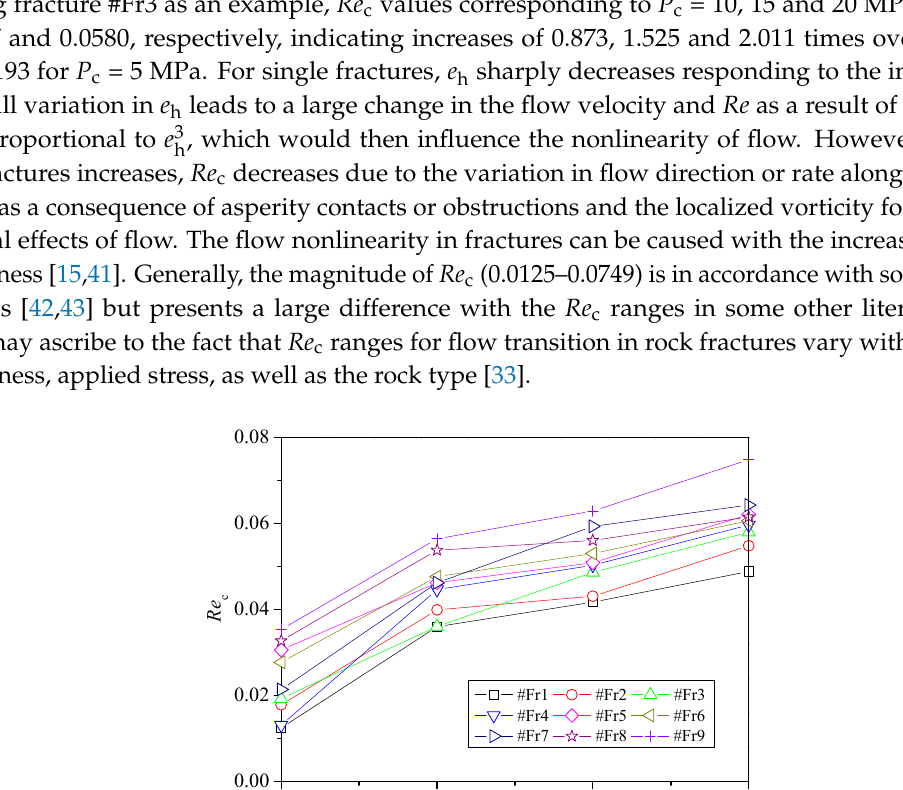
Figure 9. Critical Reynolds number Re c of rough-walled fractures versus the confining pressure. Apparent transmissivity is the product of permeability and cross-sectional area of rock fractures. If the nonlinear deviation term ( bQ 2 ) is inappreciable and can be ignored, T would be the same with the true transmissivity T 0 achieved from the Darcy’s law. Based on Equation (9), apparent